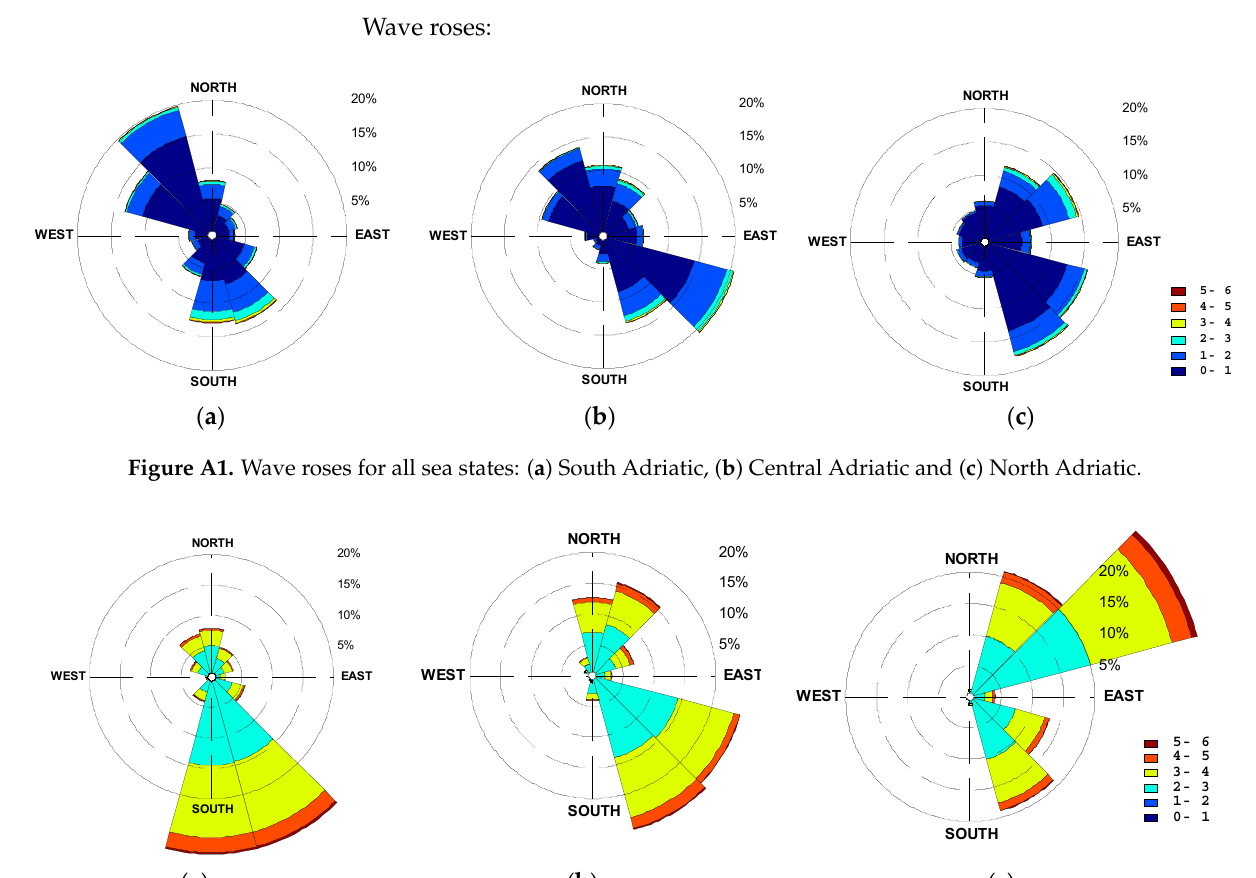
Wind speed to significant wave height simultaneous occurrence